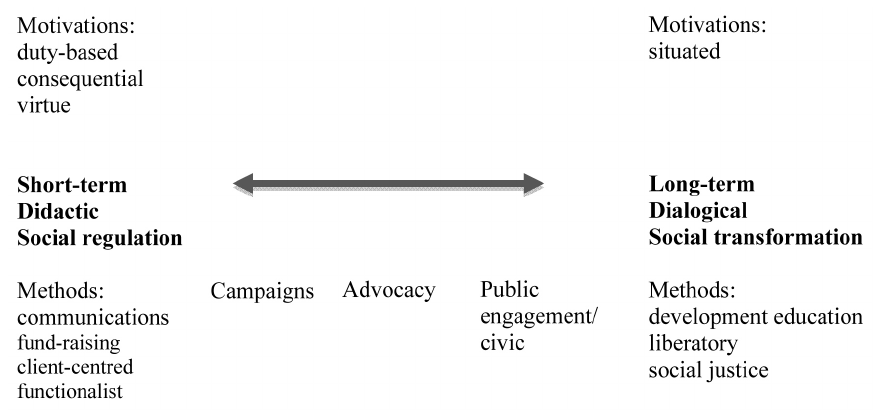
Figure 2: Motivations and methods for INGO development